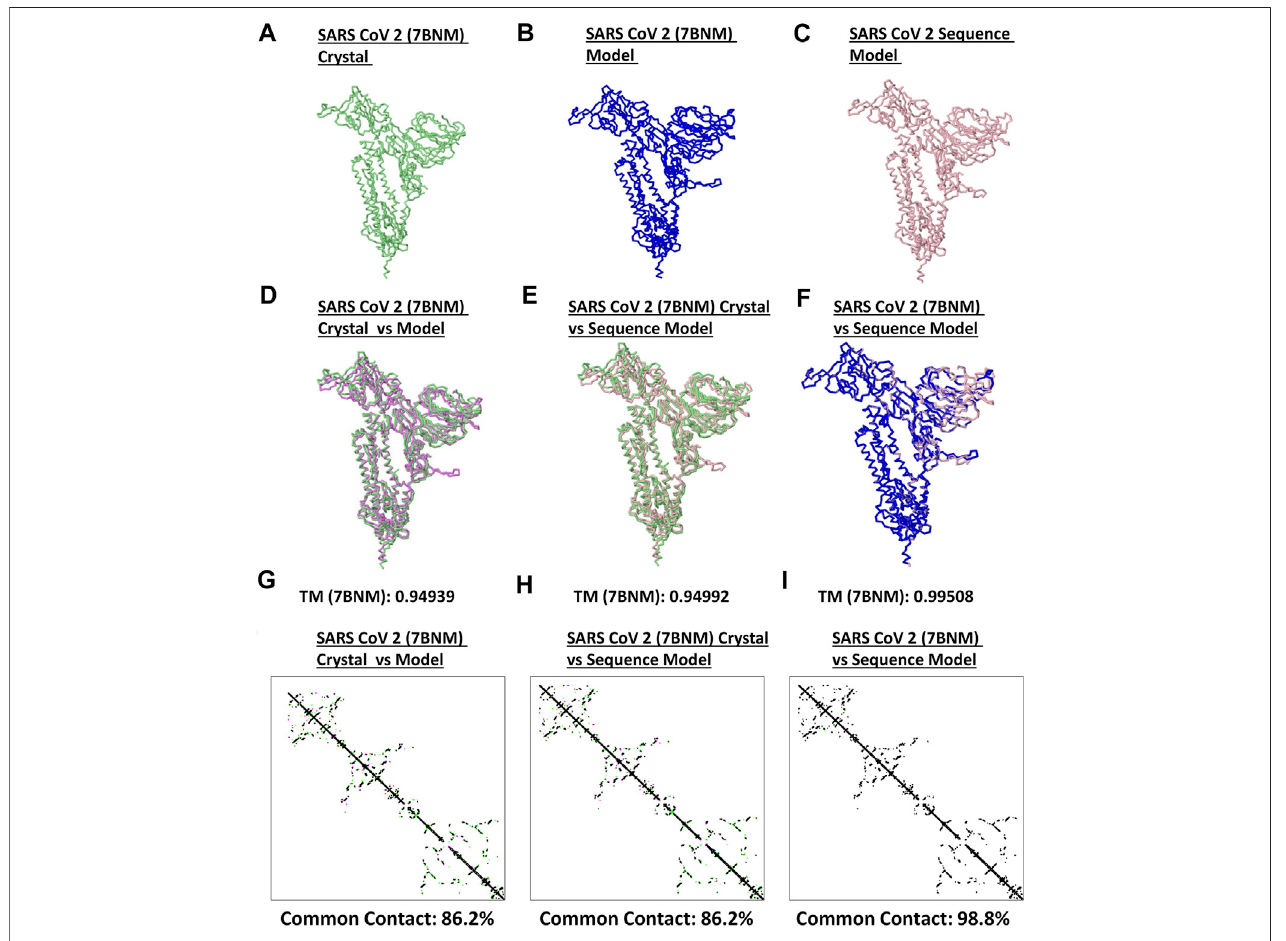
FIGURE 1 | Quality check of generated monomeric SARS2 spike protein models. Representative SARS2 (A) 7BNM crystal (B) 7BNM model, and (C) sequence modelofmonomericspikeproteinsarepresented.Superimpositionbetween (D) 7BNMcrystaland7BNMmodel (E) 7BNMcrystalandsequencemodel,and (F) 7BNM model and sequence models areshown. TMscoresrelativetothe 7BNMcrystal (whensuperimposed witheither the7BM modelor sequence model) and 7BNM model (whensuperimposedwiththesequencemodel)ofthesuperimposedproteinstructuresareindicatedbelow.SARS27BNMcrystal(green),7BNMmodel(blue),and sequence model (pink) are